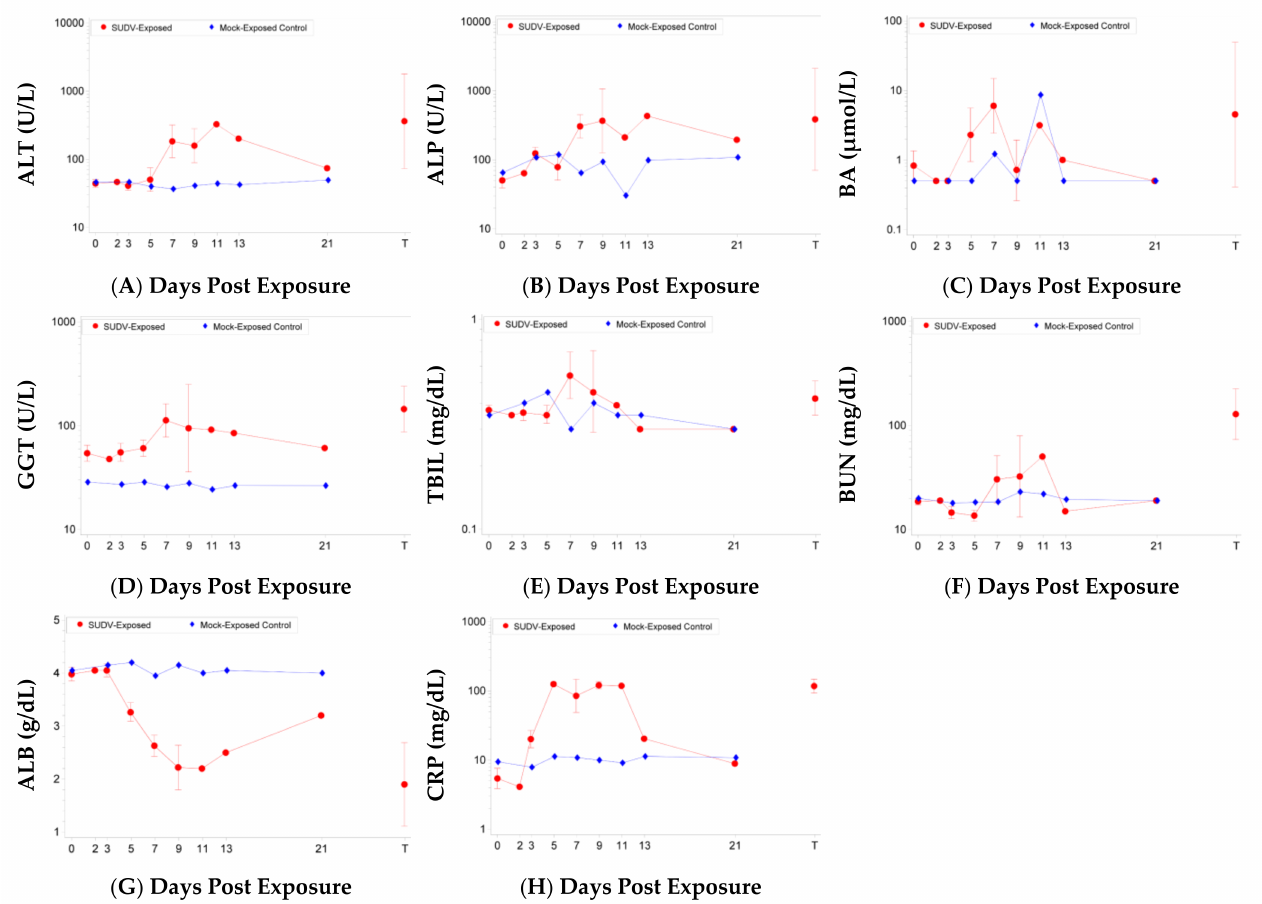
Figure 4. Clinical chemistry parameters in SUDV-exposed and mock-exposed cynomolgus macaques. Mean with 95 percent confidence intervals; confidence interval was not plotted for sample size less than 3. Unless otherwise noted, values were log-transformed and the geometric mean is displayed.